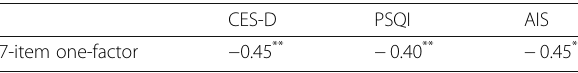
Table 3 Correlations between Chinese version of THAT score and other subjective